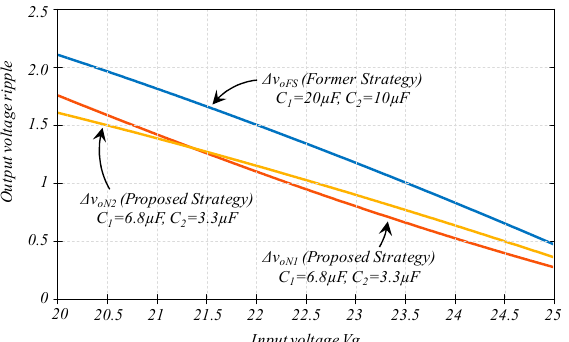
Figure 10. Zoom into the output voltage to measure the switching ripple.